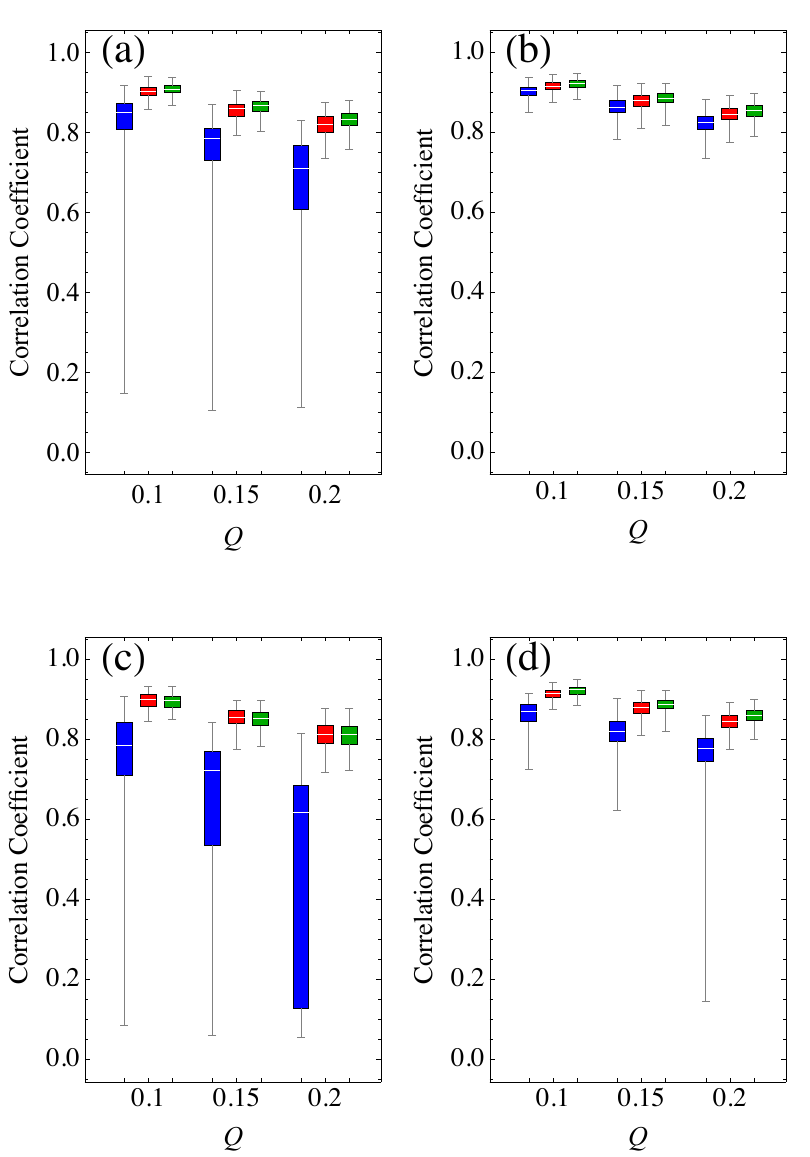
Figure 3. Box and whisker diagrams for the estimated Pearson correlation coefficients for cloning factors Q = ( 0.1,0.15,0.2 ) , in the case of a token with focusing nonlinearity n 2 = 3 × 10 − 16 cm 2 /W (blue), defocusing nonlinearity n 2 = − 3 × 10 − 16 cm 2 /W (green) and zero nonlinearity (red). For each Q , 100 different random clones were generated. The lower and upper bounds of a box refer to the first and the third quartiles, and the horizontal (white line) refers to the median. The vertical whiskers (error bars) show the minimum and the maximum of the recorded coefficients. ( a ) λ 0 = 800 nm, n 0 = 1.47, l / L = 0.2, T = 200 fs, I 0 = 1.0 × 10 13 W/cm 2 , L = 200 λ 0 , N = 1 slice. ( b ) As in ( a ) but for N = 3 slices. ( c ) As in ( a ) but for L = 400 λ 0 . ( d ) As in ( b ) but for I 0 = 2.0 × 10 13 W/cm 2